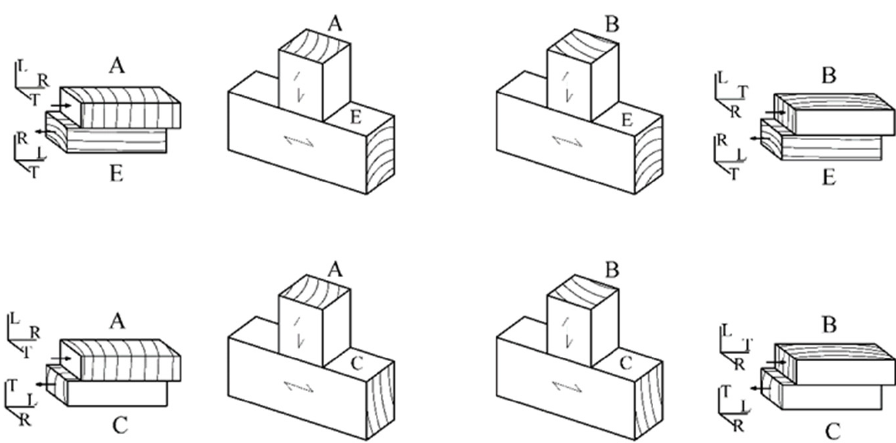
Figure 4. Contact modes studied in timber-to-timber joints and friction faces indicating the direction of slip (L—longitudinal direction, trunk axis; R—radial to growth rings; T—tangential to growth rings).